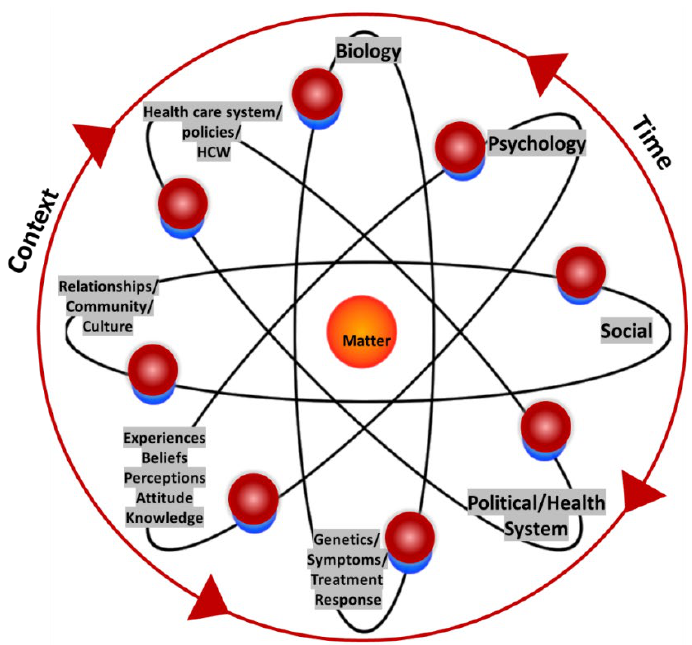
Figure 1. Biopsychosocial-material model of